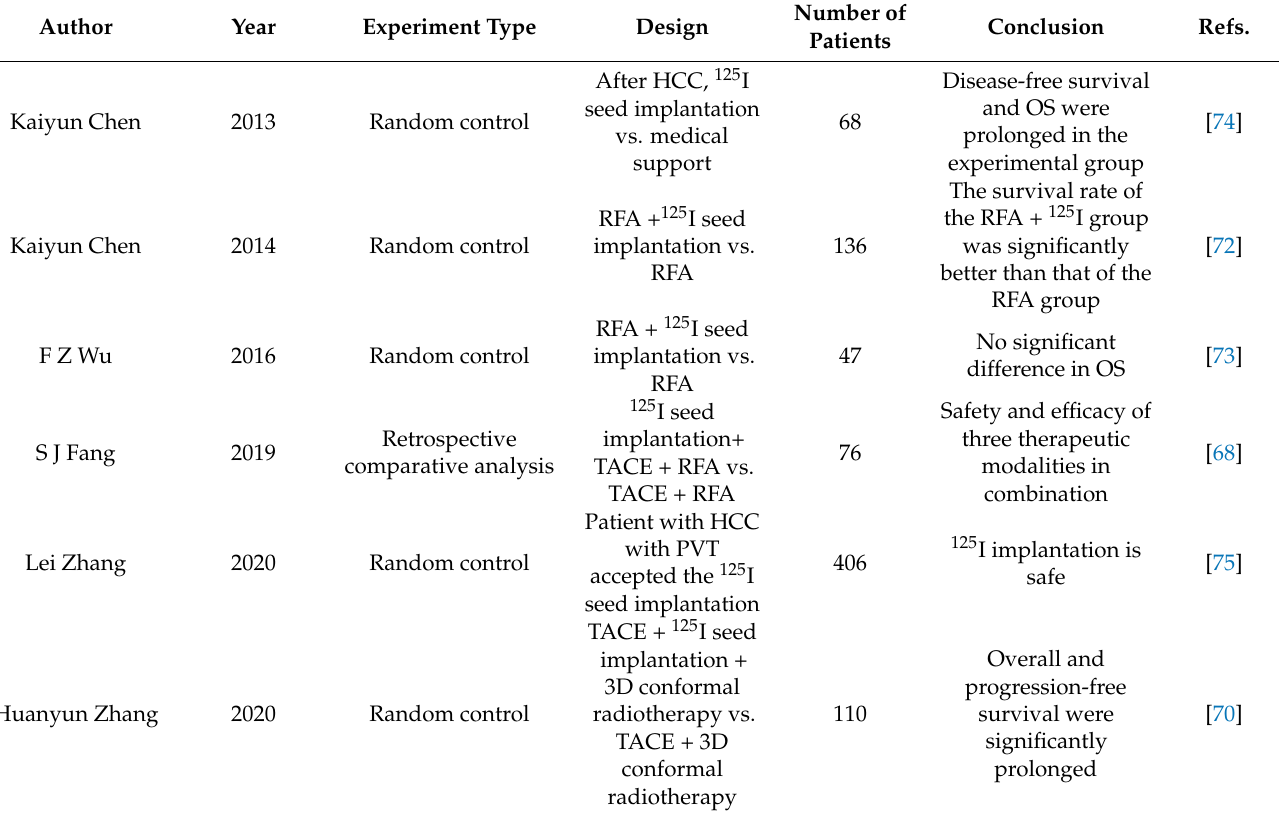
Table 5. Advances for the treatment of HCC using 125 I seed